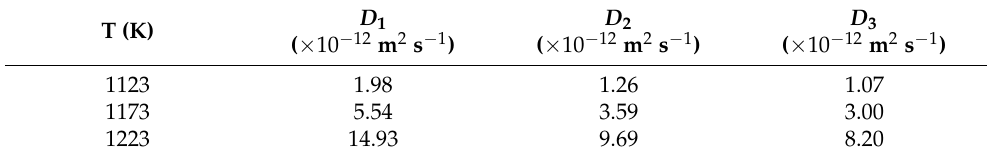
Table 3. Estimated values of boron diffusivities in nickel borides by the alternative diffusion model.